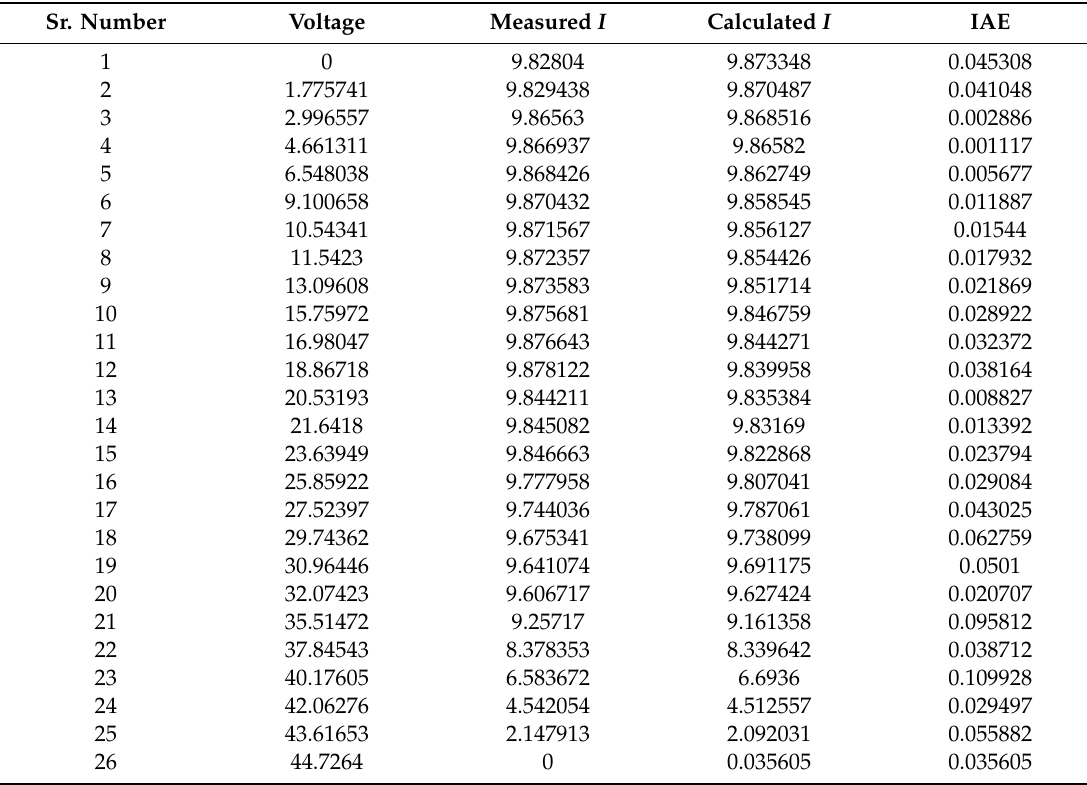
Table 15. I–V values and the relative IAE for the single-diode JKM330P-72, 310 W polycrystalline PV module.